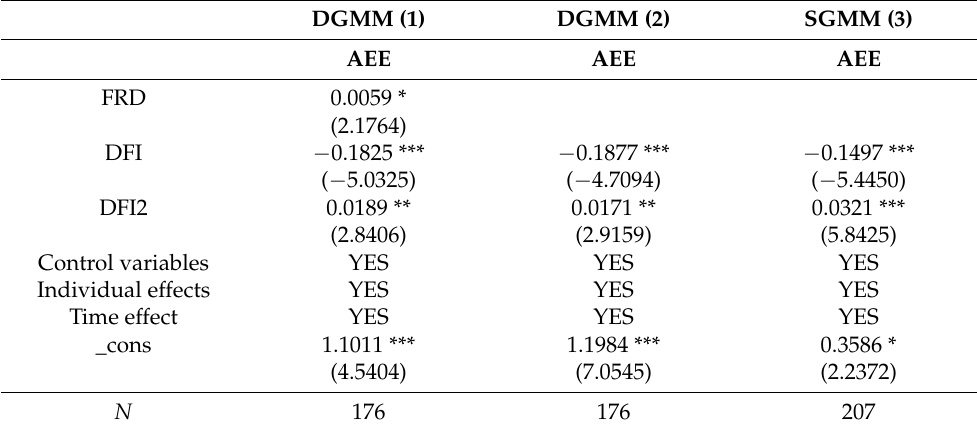
Table 5. Regression results of mechanism analysis and robustness